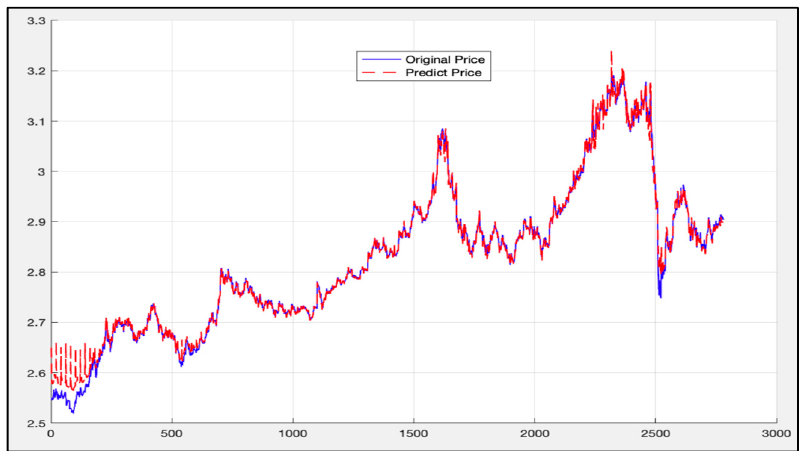
Figure 13. Comparison of Long Short-Term Memory (LSTM) prediction results with actual results (8500th data to 11,300th data).